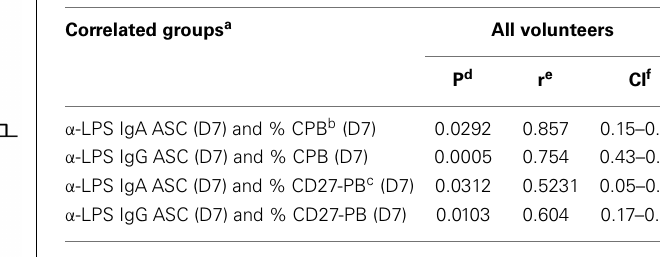
Table 3 | Correlation between anti- Shigella -LPS-ASC responses and changes in the percentages of CPB or CD27- PB cells